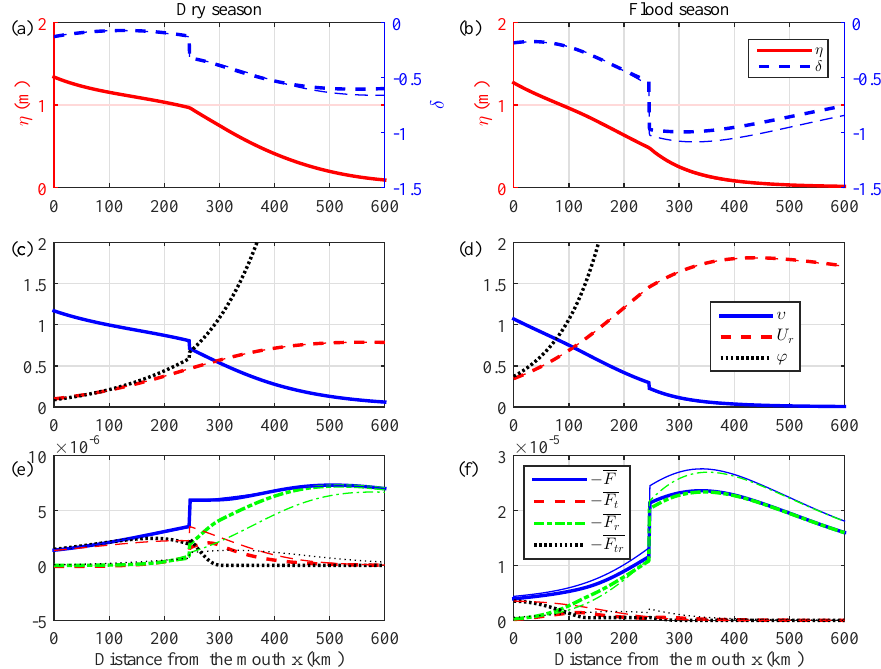
Figure A1. Longitudinal variation of the tidal amplitude and corresponding damping number (a, b) , the contributions to the flow velocity by river and tide (c, d) , and contributions of river flow and tide to the water level slope (e, f) for the dry (a, c, e) and flood season (b, d, f) in the Yangtze estuary, in which the results are the averaged values during 6–26 February 2012 (representing the dry season) and during 10–26 August 2012 (representing the flood season), respectively. The thin lines represent the results using Godin’s approximation to the friction term, while the thick lines represent the results using Dronkers’ Chebyshev polynomials approximation to the friction